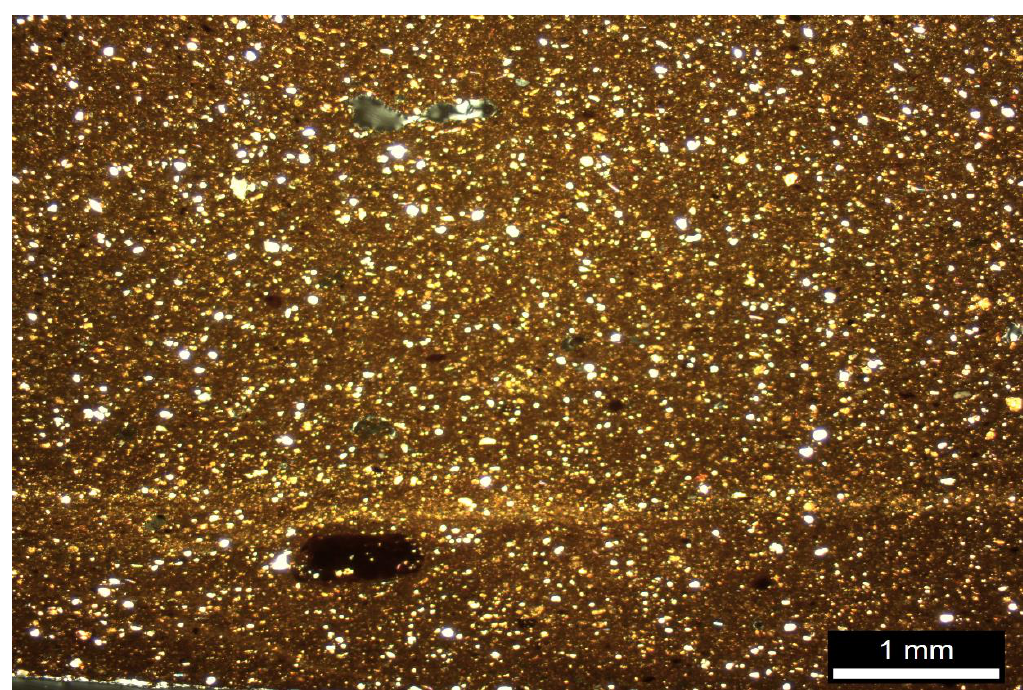
in the lower left of the image is part of an incompletely homogenized marl. Image by William Gilstrap.